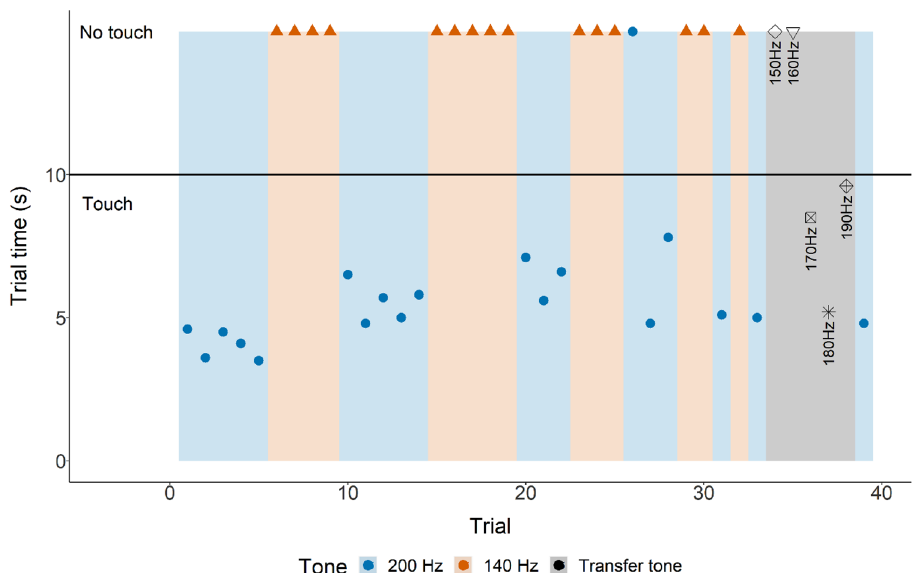
Figure 4. Individual supersession data for shark D. Touching the loudspeaker indicated by the time it took to touch (LST time). Not touching the loudspeaker is indicated by the shapes (at 15 s, indicating a capped trial i.e., the loudspeaker was not touched) above the horizontal solid black line (indicating the maximum trial time for a ‘Go’-trial). Background colour indicates each separate phase (‘Go’ phase: blue, ‘No-Go’ phase: ‘orange, transfer: